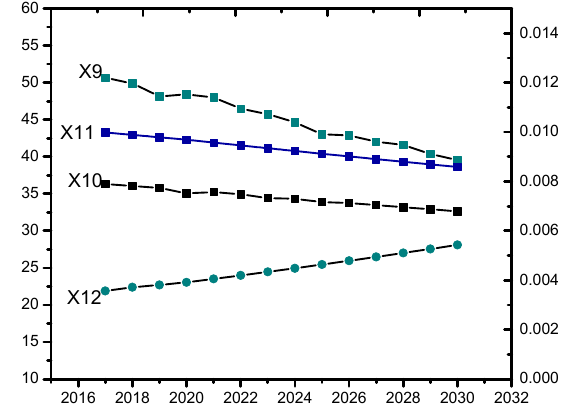
Figure 6. Predictions for the environmental sustainability of ESSI.